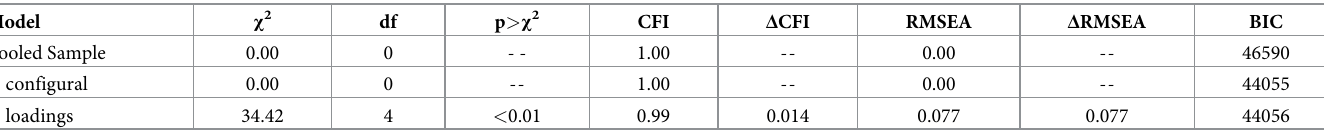
Table 3. Measurement invariance by site.